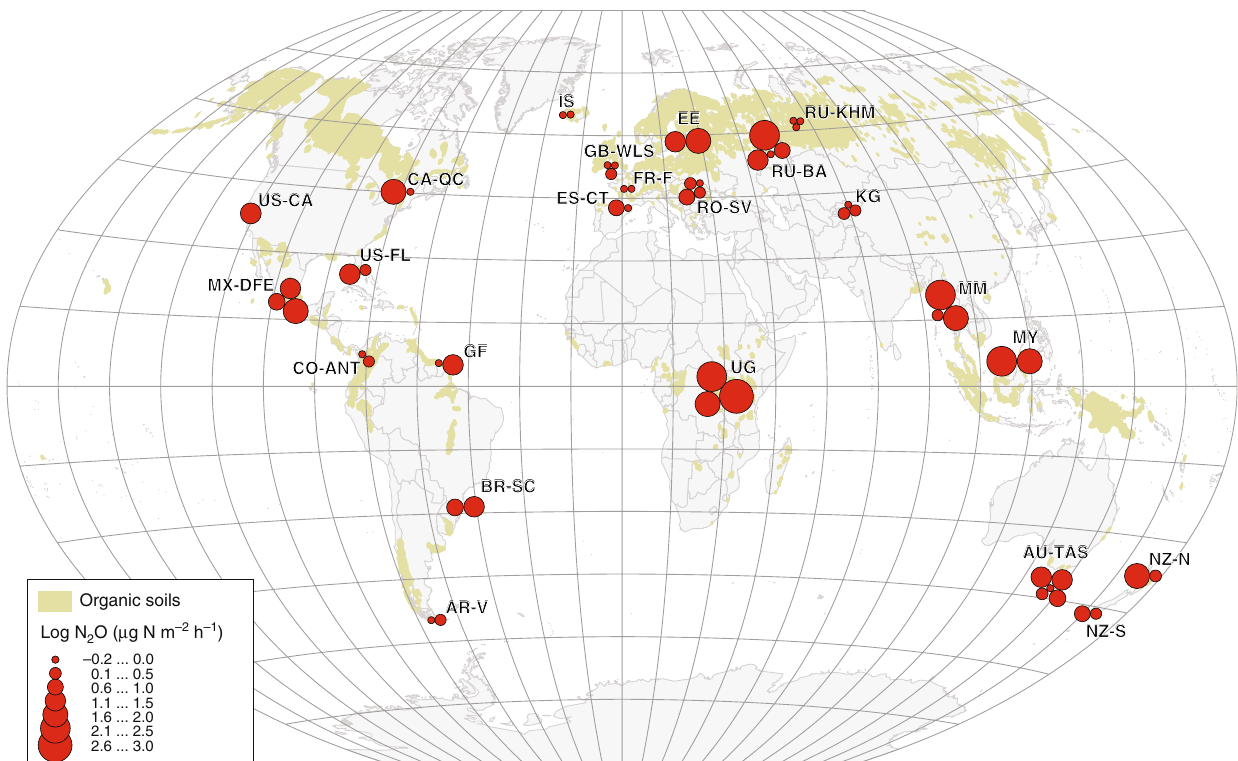
Fig. 1 Site-mean N 2 O fl uxes by study region superimposed on a global organic-soil map. Country and region codes are de fi ned after ISO 3166-2. The distribution of organic soil was de fi ned as >150 t C org ha − 1 from the Global Soil Organic Carbon Estimates (courtesy of the European Soil Data Centre)